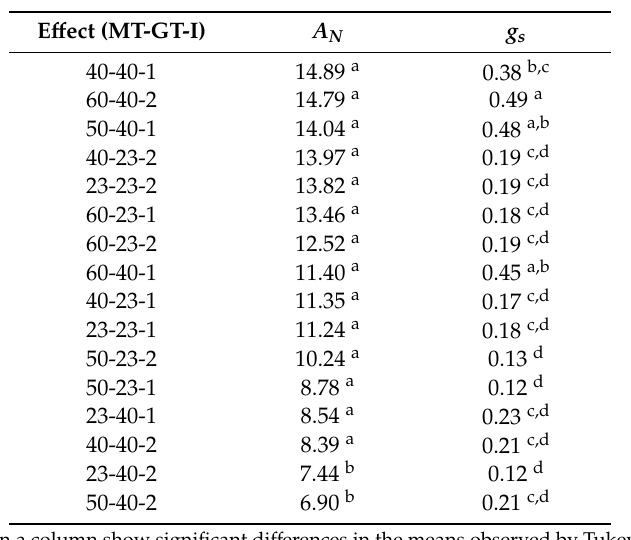
Table 6. E ff ect of di ff erent maturation temperatures (MT- ◦ C), greenhouse temperature (GT- ◦ C), and irrigation (1) or no irrigation (2) conditions (I) on the instantaneous net photosynthesis ( A N , µ mol